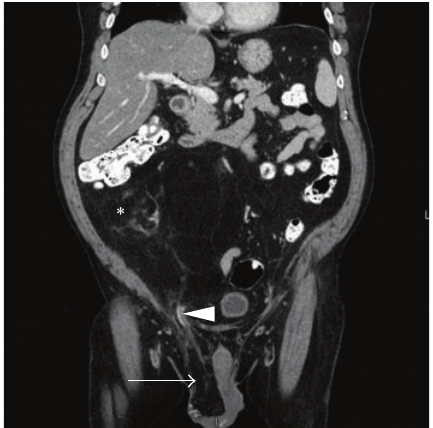
Figure 3: CT abdomen and pelvis with IV contrast, coronal image, demonstrating a large fatty lesion with associated soft tissue component in the right peritoneum extending into the right lower quadrant along the right paracolic gutter measuring 10.3 × 7.4 cm and 18.1 cm in superior to inferior direction. The lipomatous lesion extends into the inguinal canal (white arrowhead) resulting in right- sided inguinal hernia (white arrow). There is an area of ill-defined